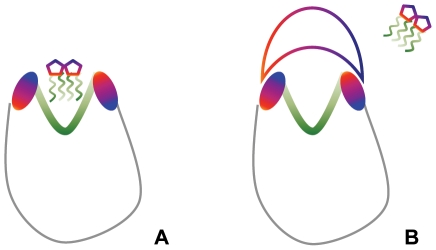
Schematic representation of the proposed mechanism of action of partially glycosylated dendrimers on human MD-2.Green – hydrophobic residues. Red and blue – hydrophilic regions.